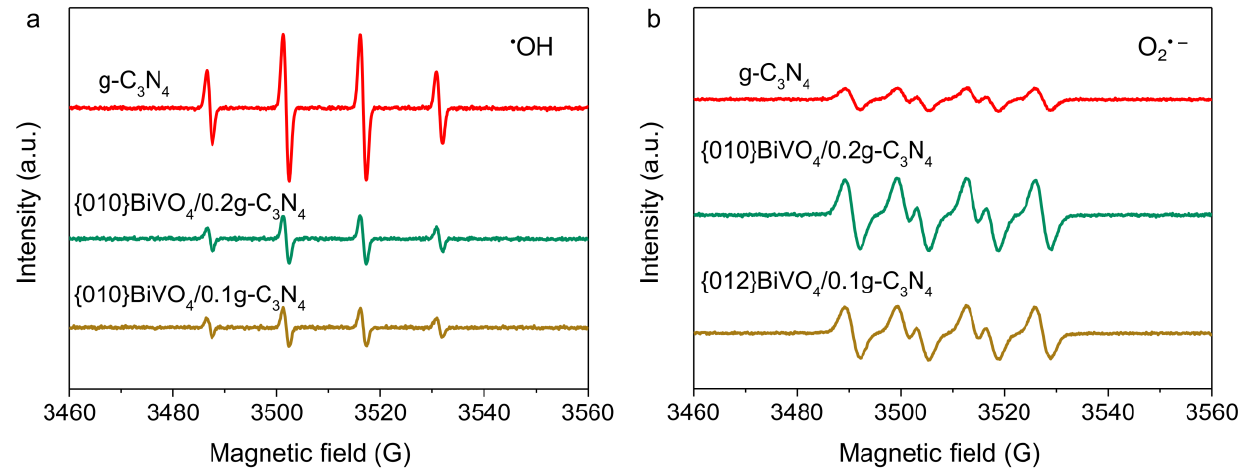
Figure 5. ( a ) EPR spectra of • OH and ( b ) O 2• − radicals for g-C 3 N 4 , {010}BiVO 4 /0.2g-C 3 N 4 , and {012}BiVO 4 /0.1g-C 3 N 4 .